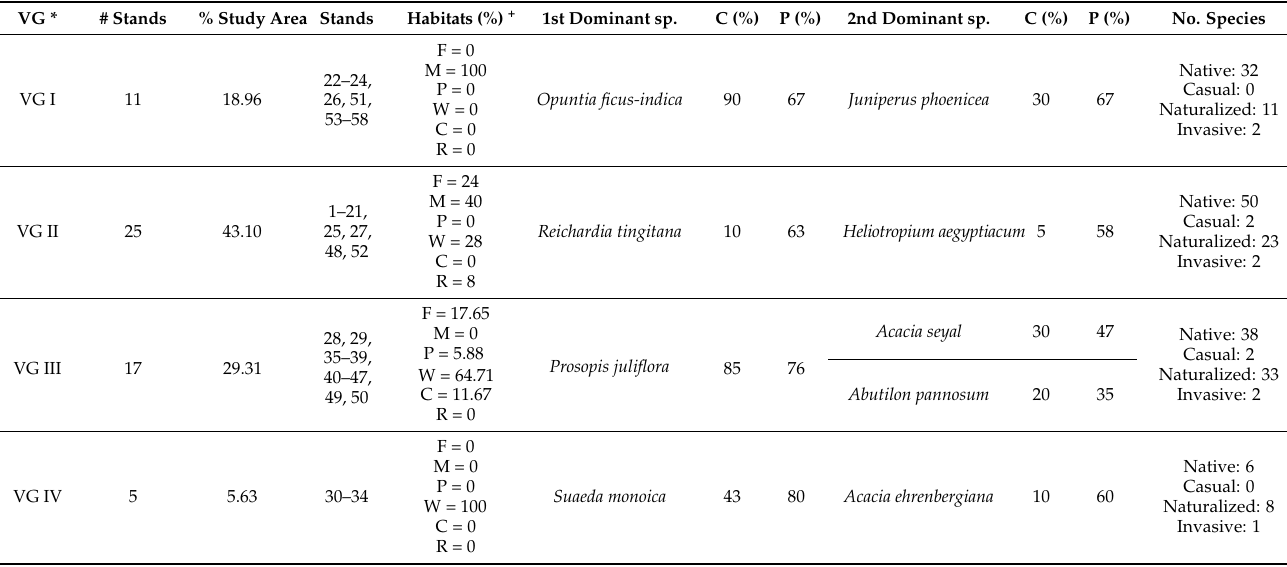
Table 1. Different vegetation groups identified in the study with the sampling stands belonging to each group, the habitats each group inhabits, and the dominant species based on their average coverage and relative frequency values. Numbers of native and alien species in each vegetation group are